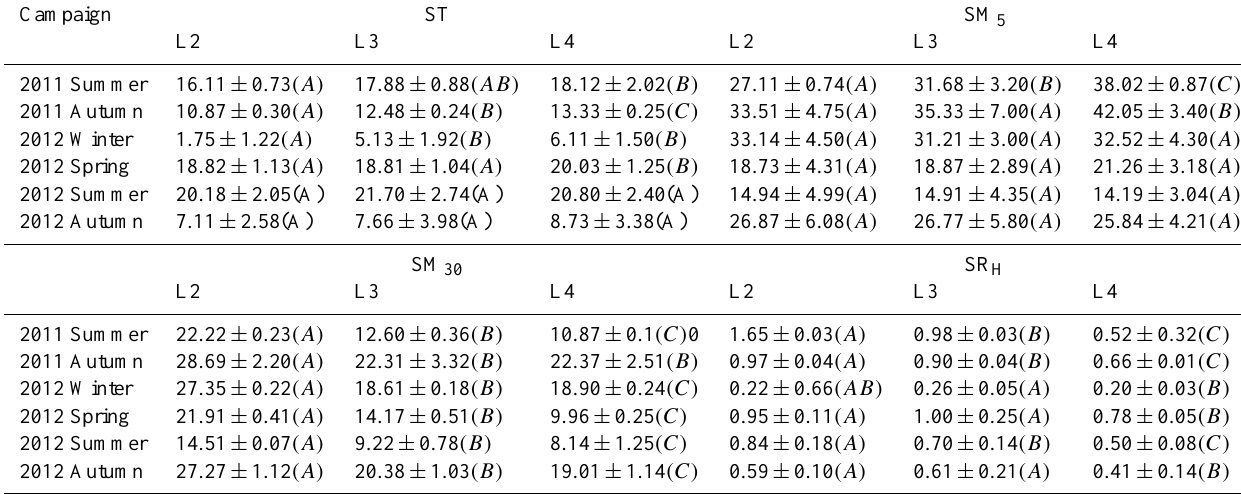
Table A1. Analysis of variance (ANOVA) statistics for soil temperature (ST) and soil moisture (SM): SM 5 , SM 30 and heterotrophic soil res- piration (SR H ) of different levels of the same season (mean ± SD). LSD was used to test post hoc. Means with the same letter in parentheses are not significantly different ( P < 0 .